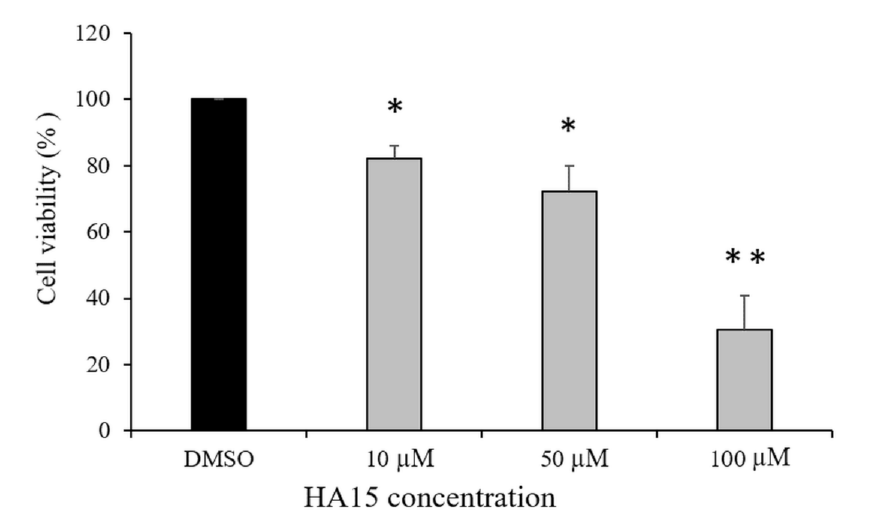
Figure 1. Viability of normal human melanocytes in response to increasing HA15 concentration under normal culture conditions after 48 h of treatment. DMSO is the solvent for HA15. The viability of cells was detected using the WST-1 assay. The data are presented as the mean ± SD of three independent experiments. Asterisks represent significant differences (* p ≤ 0.05; ** p ≤